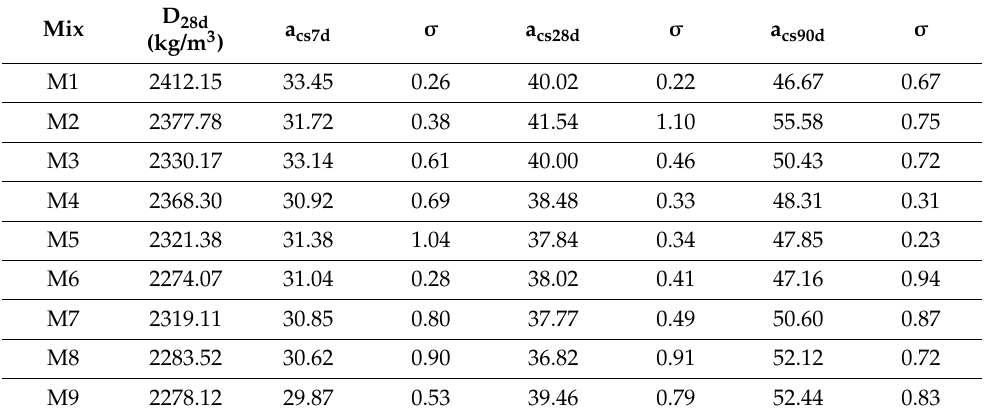
Table 7. Density and compressive strength